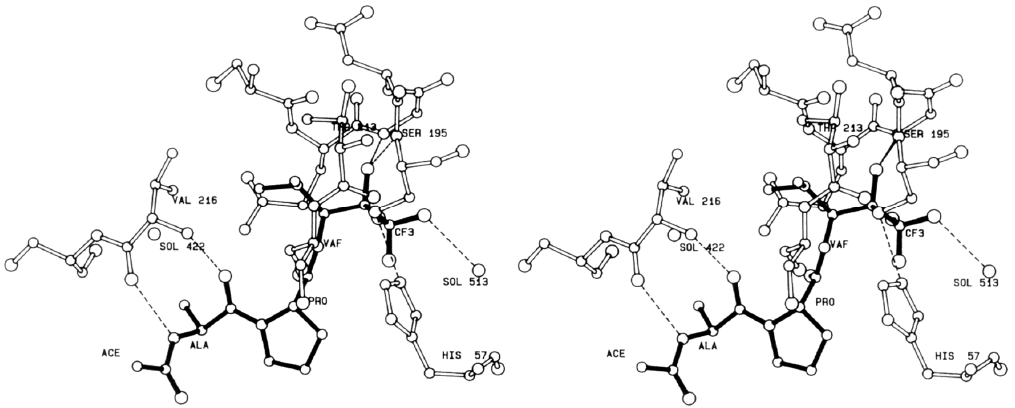
Figure 14. A stereo view of the inhibitor Ac-Ala-Pro-Val-CF 3 in the extended binding site of porcine pancreatic elastase [116].